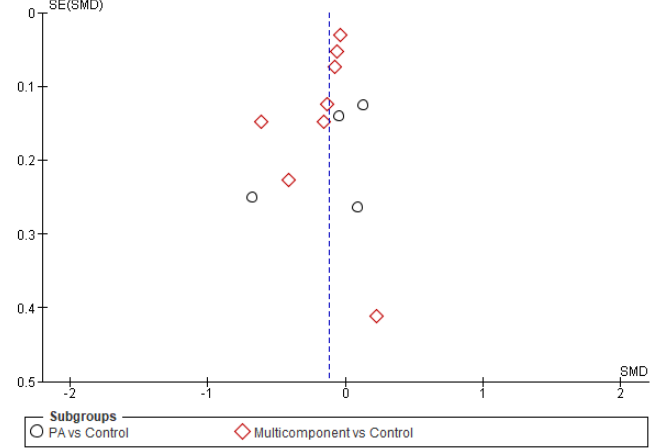
Figure 4. Forest Plot. Black diamond—Overall effect, 95% IC; Green box—study weight [24–35].